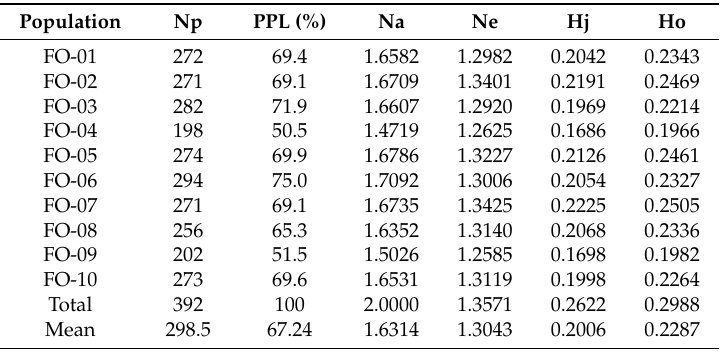
Table 2. Genetic variability in 10 Festuca ovina populations. Number of polymorphic loci (Np), percentage of polymorphic loci (PPL), observed number of alleles per locus (Na), effective number of alleles per locus (Ne), Nei’s gene diversity index (Hj), Shannon diversity index (Ho).